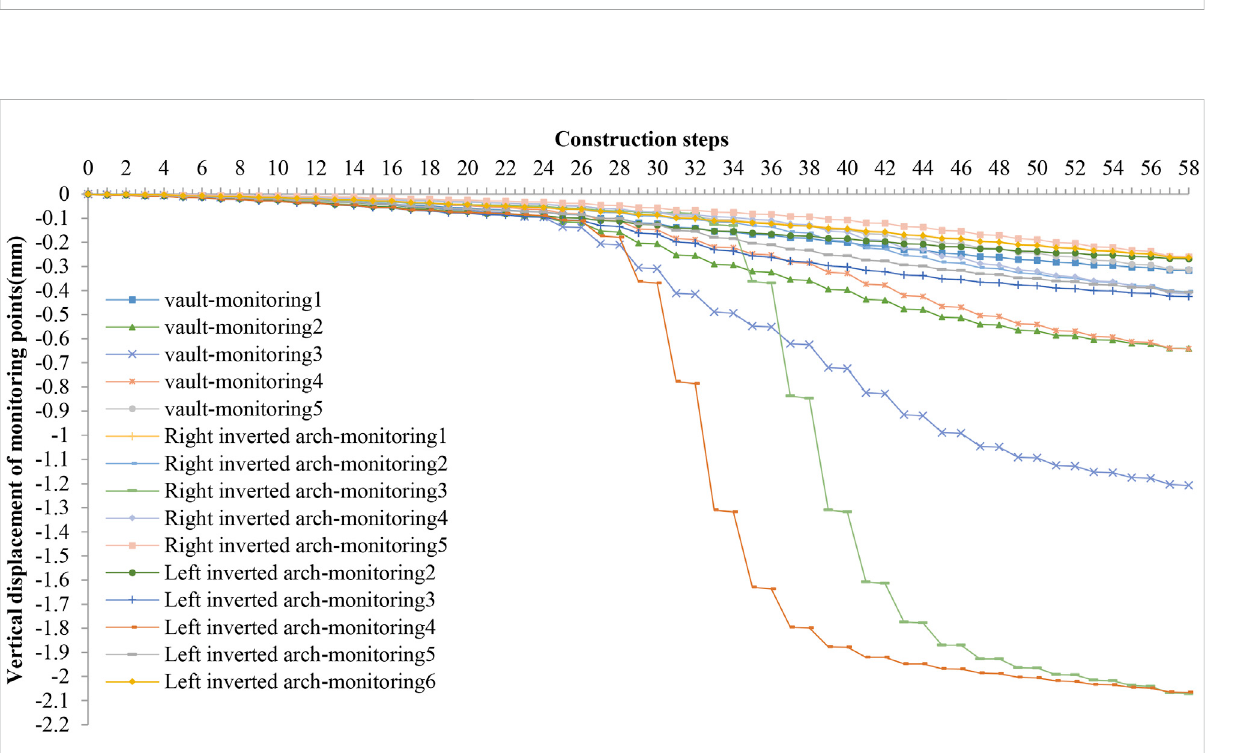
FIGURE 6 Vertical displacement of monitoring points of the right